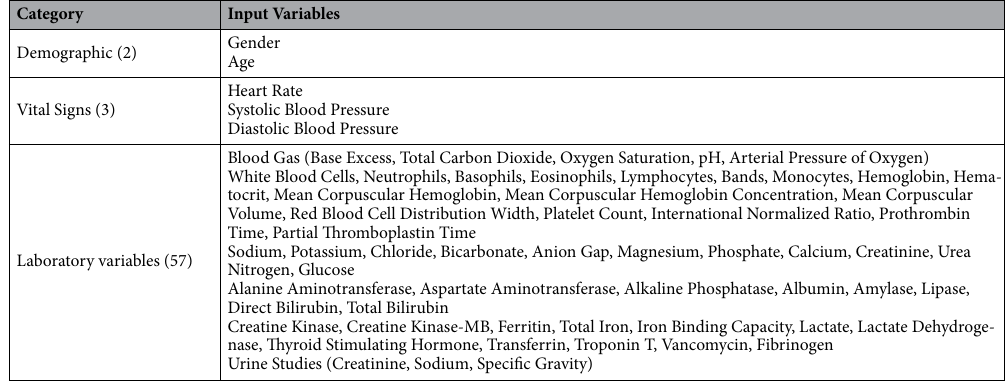
Table 2. Input variables (N = 62).